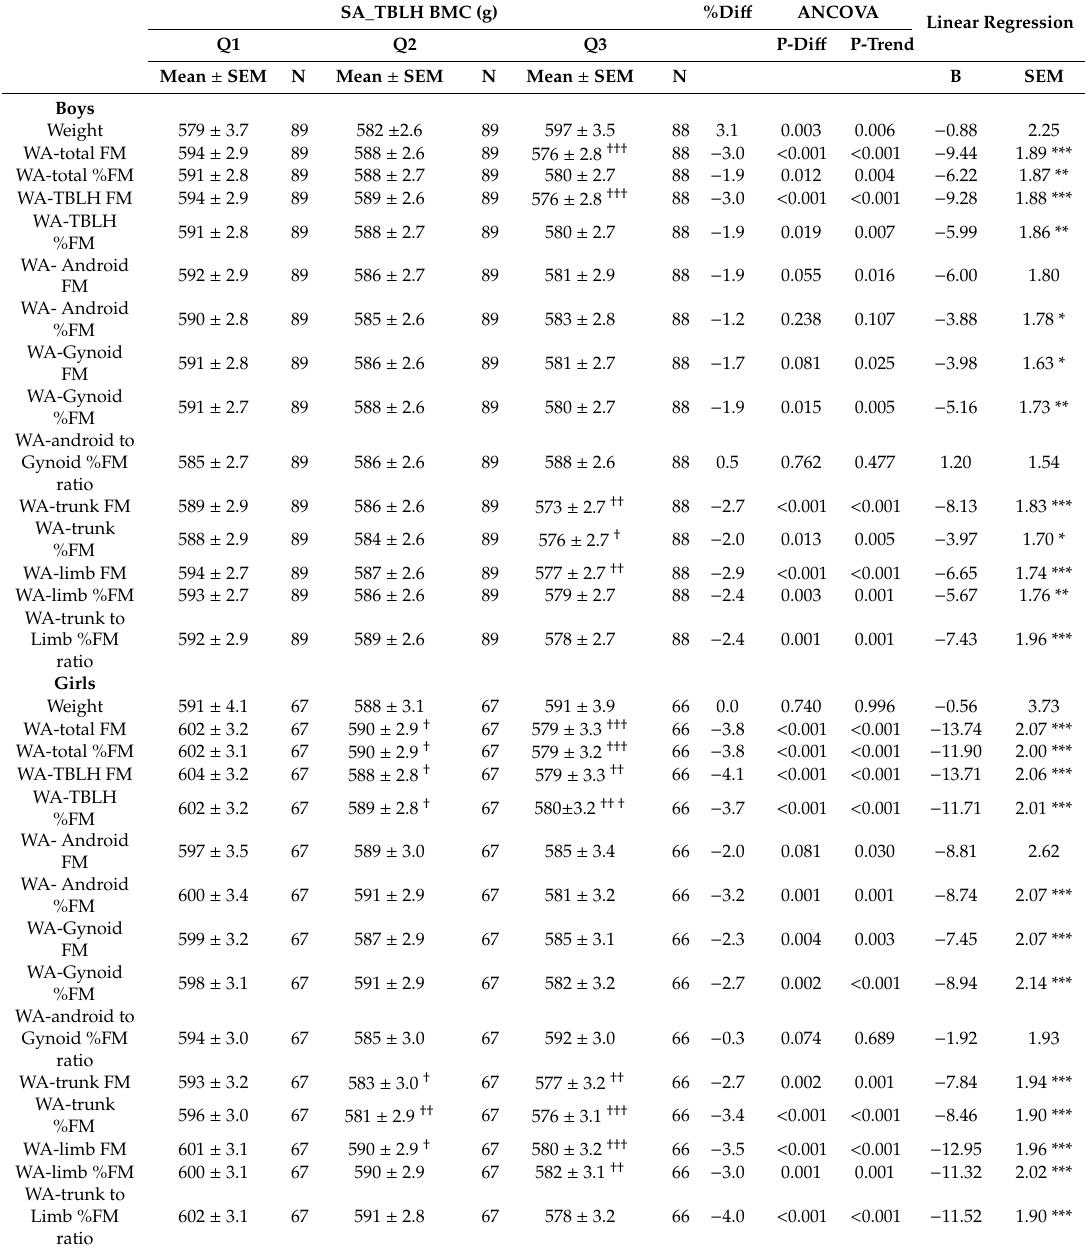
Table 4. Covariate-adjusted mean (SEM) SA_TBLH BMC by tertiles of each WA-index of